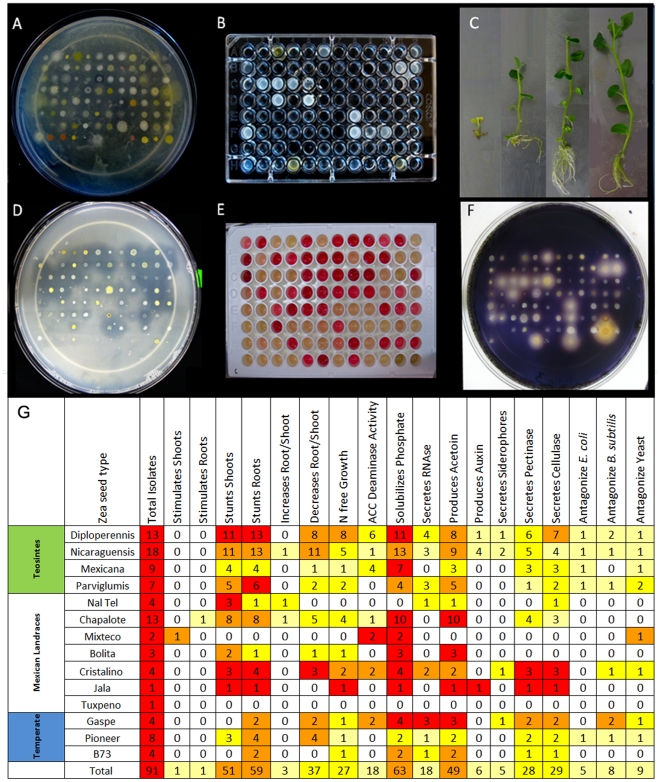
Analysis of functional traits of endophytes cultured from Zea seed.Shown are (A–F) select examples of trait assays and (G) the complete summary grouped by Zea genotype. Shown are assays for (A) antagonism to E. coli; (B) growth in nitrogren free LGI media with only ACC as a nitrogen source; (C) growth promotion of tissue cultured potato one month after inoculation with (from L–R) Enterobacter cloacae, Cellulomonas denverensis, sterile buffer, or Burkholderia phytofirmans; (D) ability to solubilise tricalcium phosphate; (E) acetoin and butanediol production; and (F) extracellular digestion of cellulose. For panel (G), light yellow shading indicates that <25% of isolates from the Zea genotype indicated exhibited the trait, deep yellow indicates 25–50%, orange indicates 50–75%, and red indicates 75–100%.